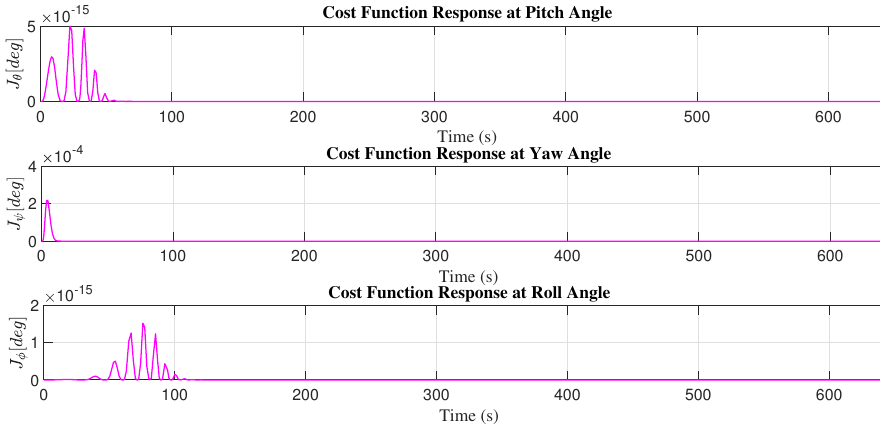
Figure 16. Minimization of J θ , ψ , φ with MIT rule with sliding modes